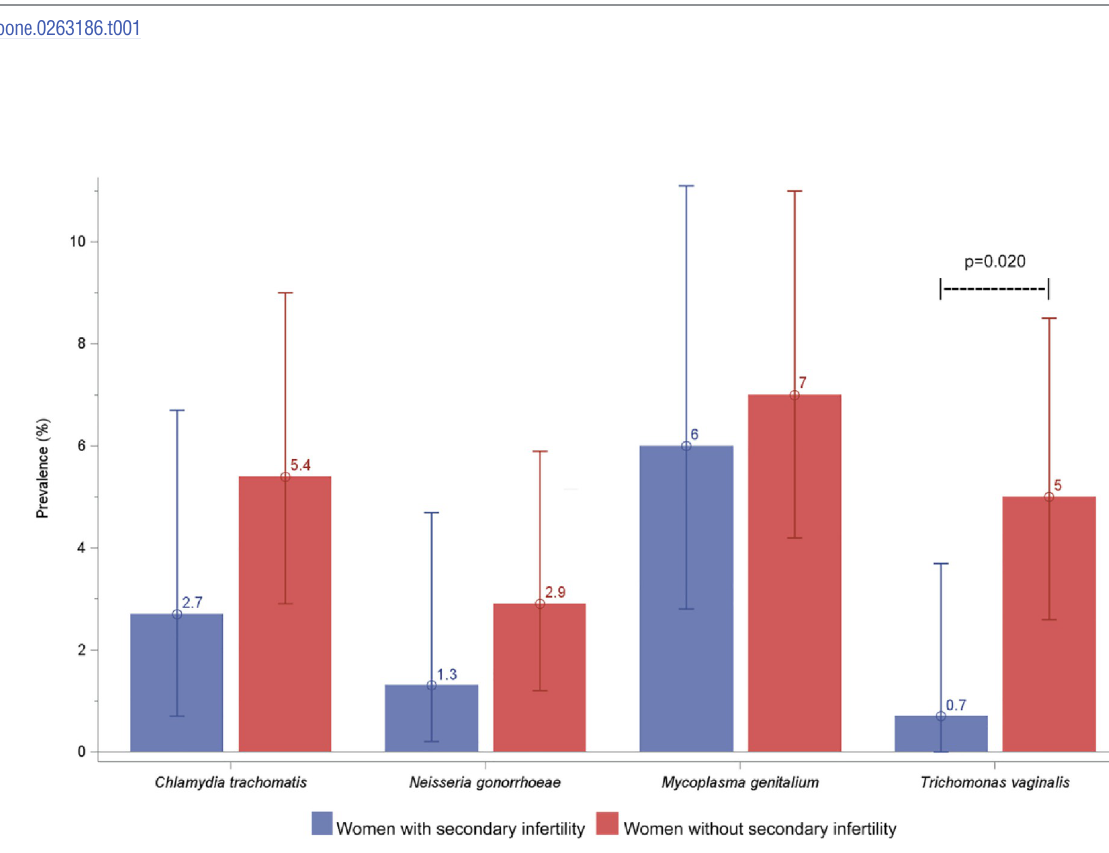
Fig 1. STI prevalence (CT/NG/MG/TV) among cases and